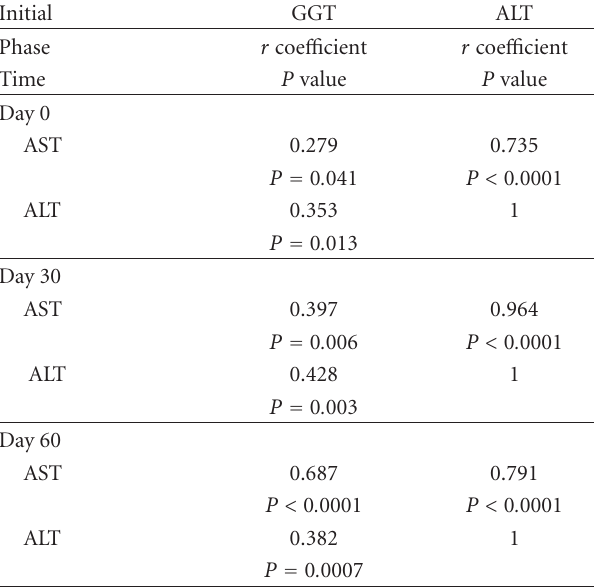
Table 1: Simple correlation coe ffi cients r between liver enzymes according to the initial phase therapy